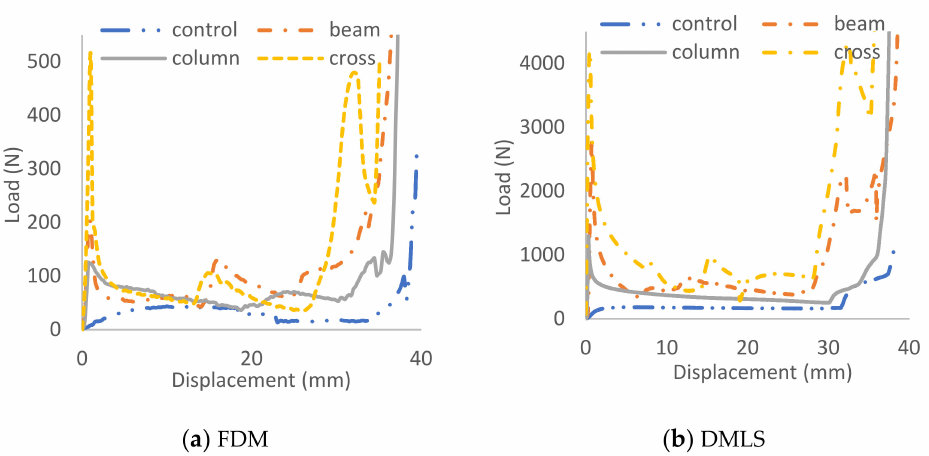
Figure 5. Compressive load-displacement history of hexagonal cellular configurations made with ( a ) FDM and ( b ) DMLS